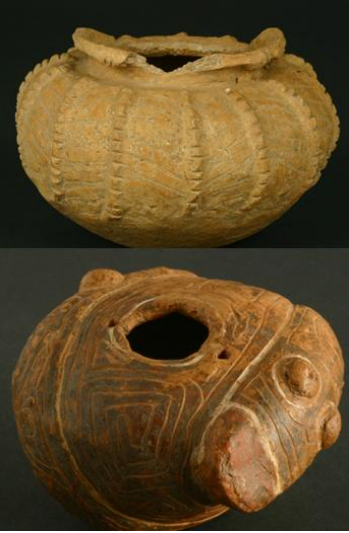
Figure 7. Depiction of snakes over Marajoara phase vessels. Banco Santos collection, at Museu de Arqueologia e Etnologia at the University of São Paulo. Photographs by Denise